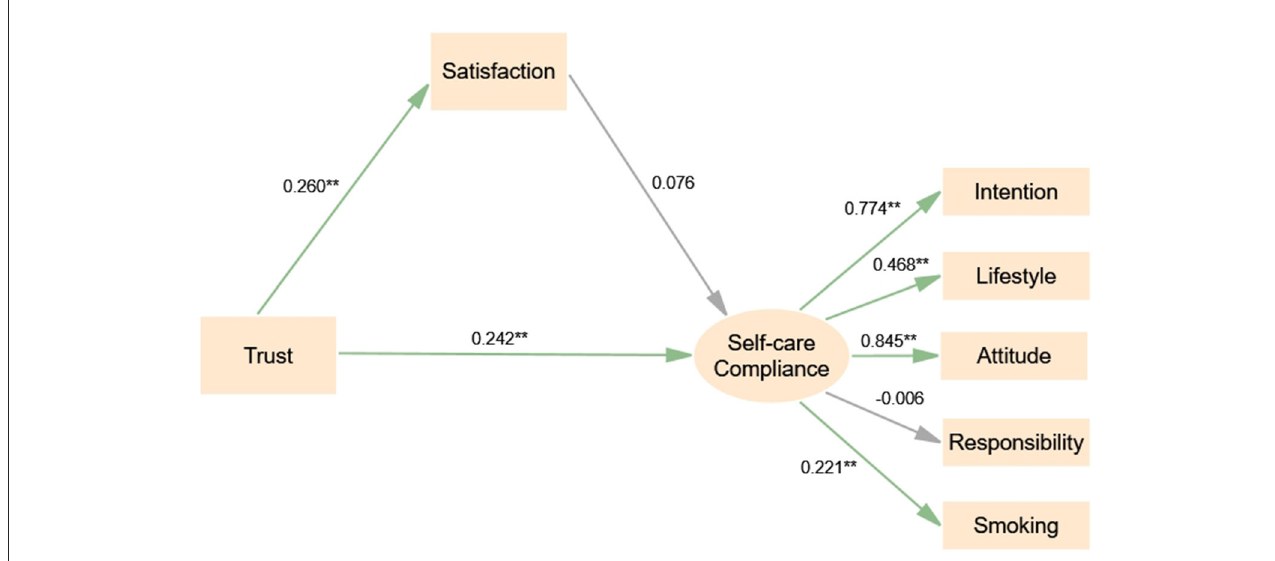
FIGURE2 Structural equation model of trust, satisfaction and compliance (full sample). Significant codes: ** P < 0.01; * P <